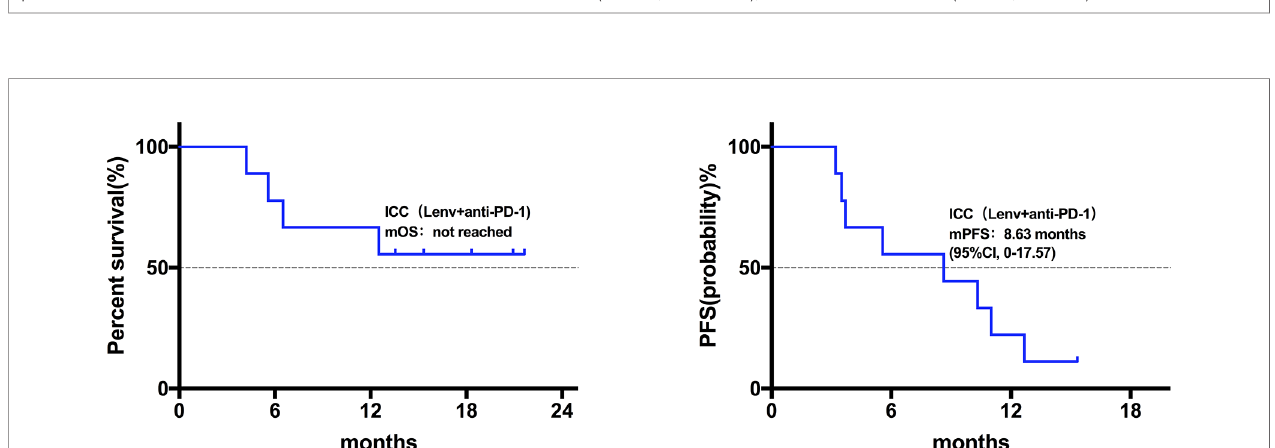
FIGURE 3 | Kaplan-Meier estimates of overall and progression-free survival in HCC patients treated with anti-PD-1 combine with Lenvatinib. The mOS of HCC patients treated with anti-PD-1 combined with Lenvatinib was 21.77 months (95% CI, 3.68-39.86), mPFS was 7.10 months (95% CI, 2.8-11.4).